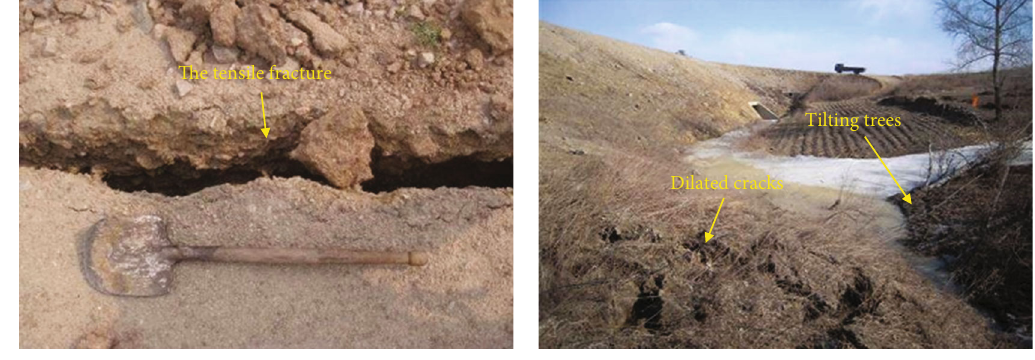
Figure 3: The tensile crack in sliding body.